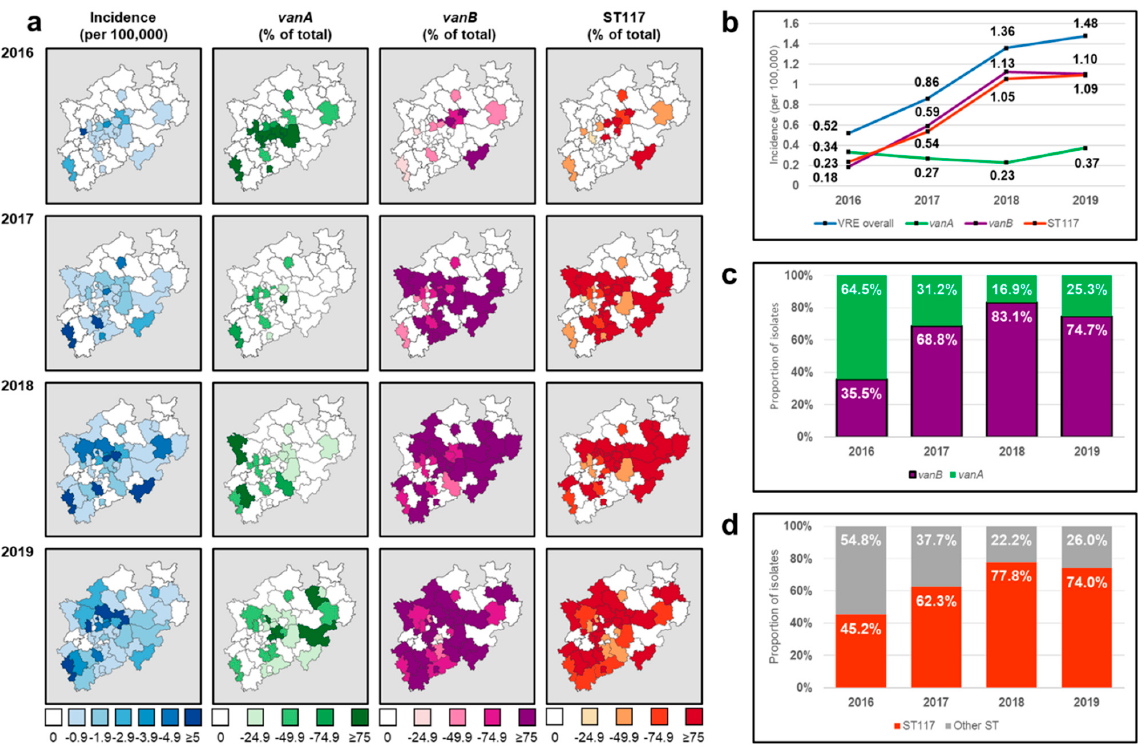
Figure 3. Temporal and spatial spread of VREBIs in NRW between 2016 and 2019: ( a ) geographic spread of VREBIs across administrative districts; ( b ) evolution of VREBI incidence; ( c ) distribution of resistance determinants; ( d ) proportion of ST117.